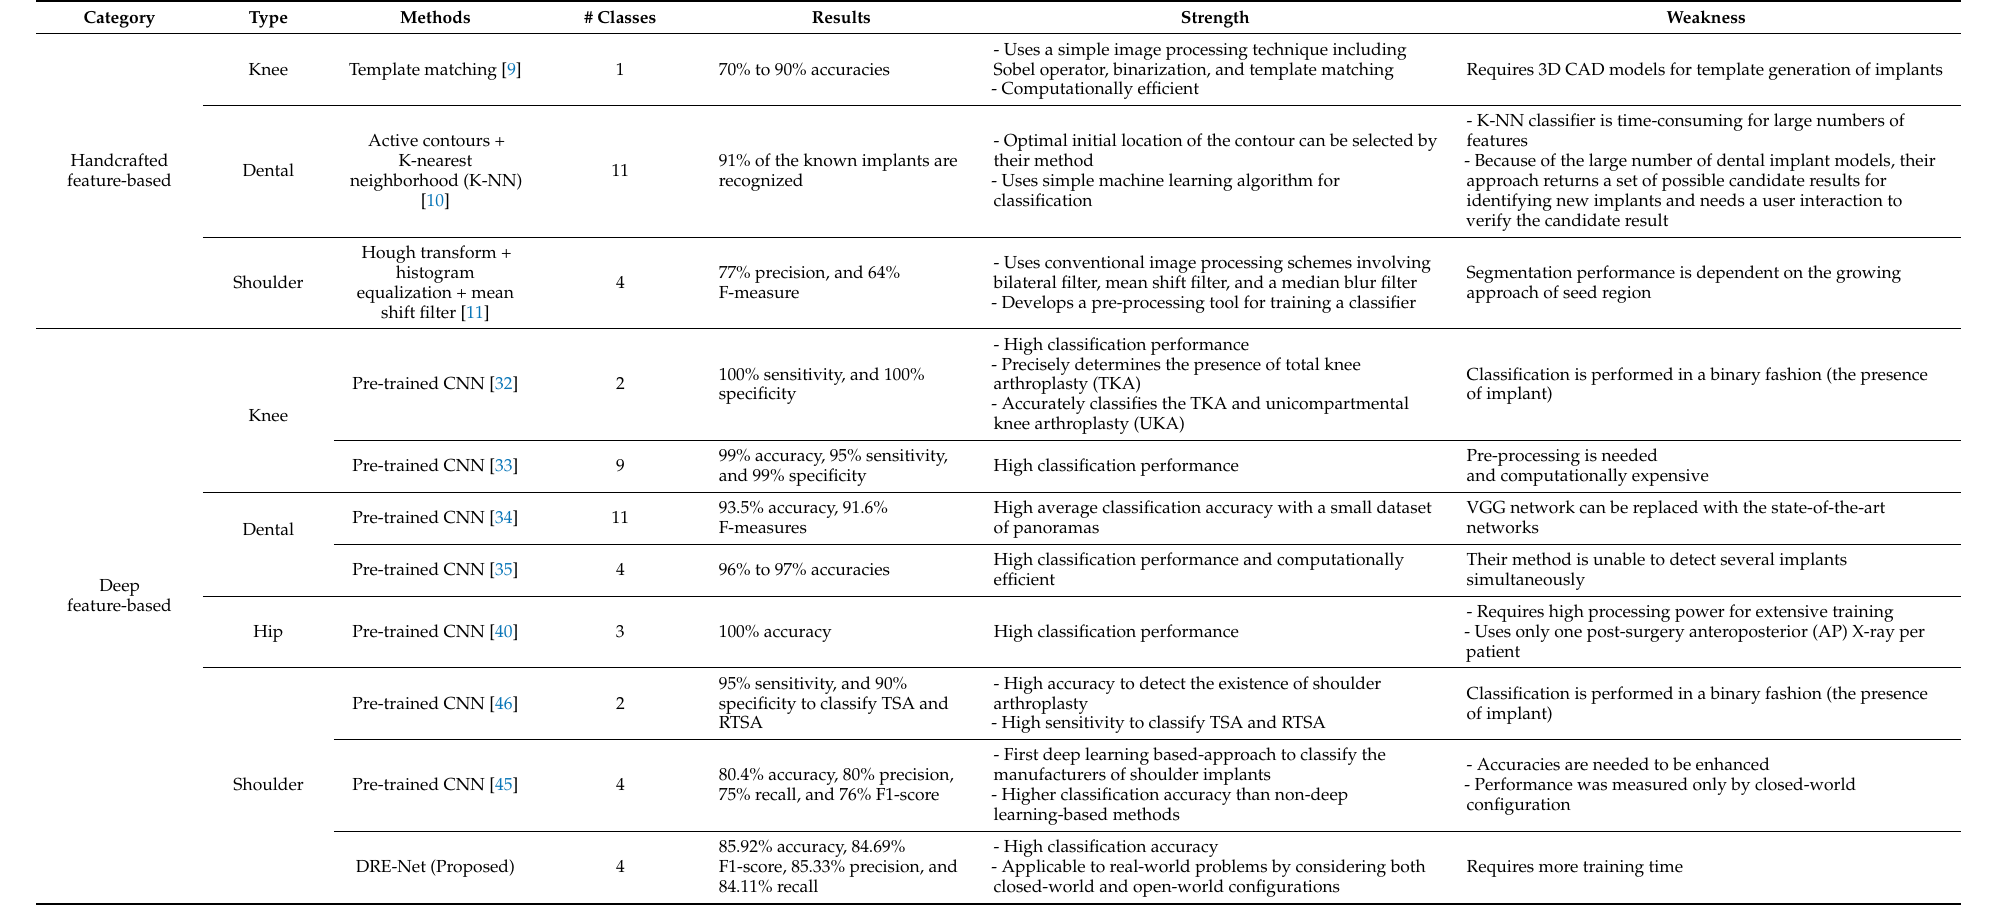
Table 1. Comparisons between our proposed and previous methods for implant recognition in X-ray